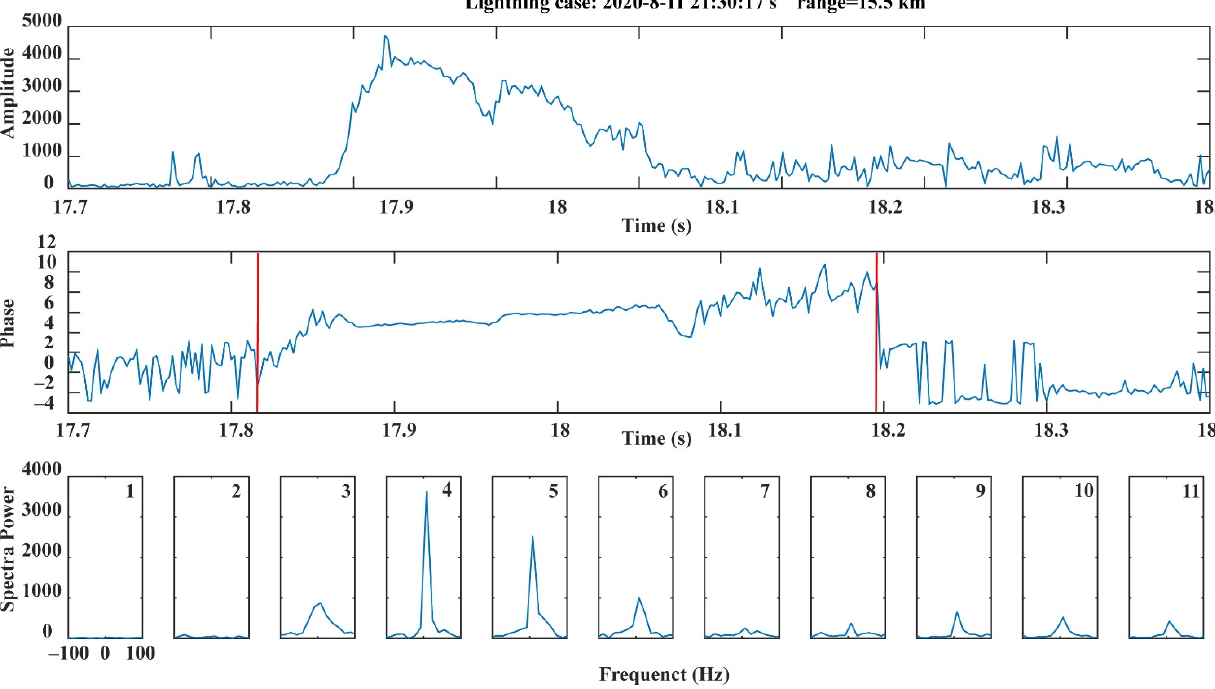
Figure 5. Amplitude, phase, and doppler spectra of I\Q raw data. The doppler spectra windows are numbered in the right corner of the subpanel. Each subpanel is calculated using 32 data points of the selected raw complex signal. The amplitude of the return echo rises abruptly out of the noise and reaches quasi- saturation which is due to the characteristics of the overdense lightning channel. There are three temporary valleys of amplitude on the saturation stage along with correspond- ing changes of the phase, which might indicate that branches of the lightning channel result in a change of the scattering center [44]. The overall performance of amplitude accords with an overdense channel being modeled as a metallic cylinder that expands with time [48,54]. The decay of amplitude is exponential, which is consistent with the assumption that the ionized channel becomes underdense with the lapse of time. It means that the transmitted electromagnetic wave can penetrate the lightning channel and the backscattered signal is the sum of scattering from individual electrons [34,35,43]. The result of 3D imaging of the lightning channel is shown in Figure 6. Based on the interferometry method described above, AOAs and corresponding ranges can be calcu- lated to obtain the three-dimensional location of the target point. The spatial structure of the lightning channel can be clearly seen in the x-y-z plane. The labels of x-y plane are substituted with East<-West and North<-South. The radar sta- tion is marked as a red pentagram. The location of lightning channels reported by the VLF lightning detection system occurring at the same time are chosen for comparison. The de- tailed data format of the VLF locating system offered by IEECAS is listed at the end of the section in Table 2. The latitude and longitude information along with the height are used to form a red round ball in the 3D result. However, the VLF locating results only have a point which may not fit well with the fine 3D structure of the VHF result. To the conven- ience of observation, the 2D result of the project of x-y plane is depicted in Figure 6 (b). The location of the VLF lightning detection system in the 2D plane are within a small distance, but the height is not in well agreement with results of the VHF system in the 3D view. The deviation between two results is reasonable since the VLF lightning mapping are performed with multiple stations from a long distance, which might lead to possible locating errors.